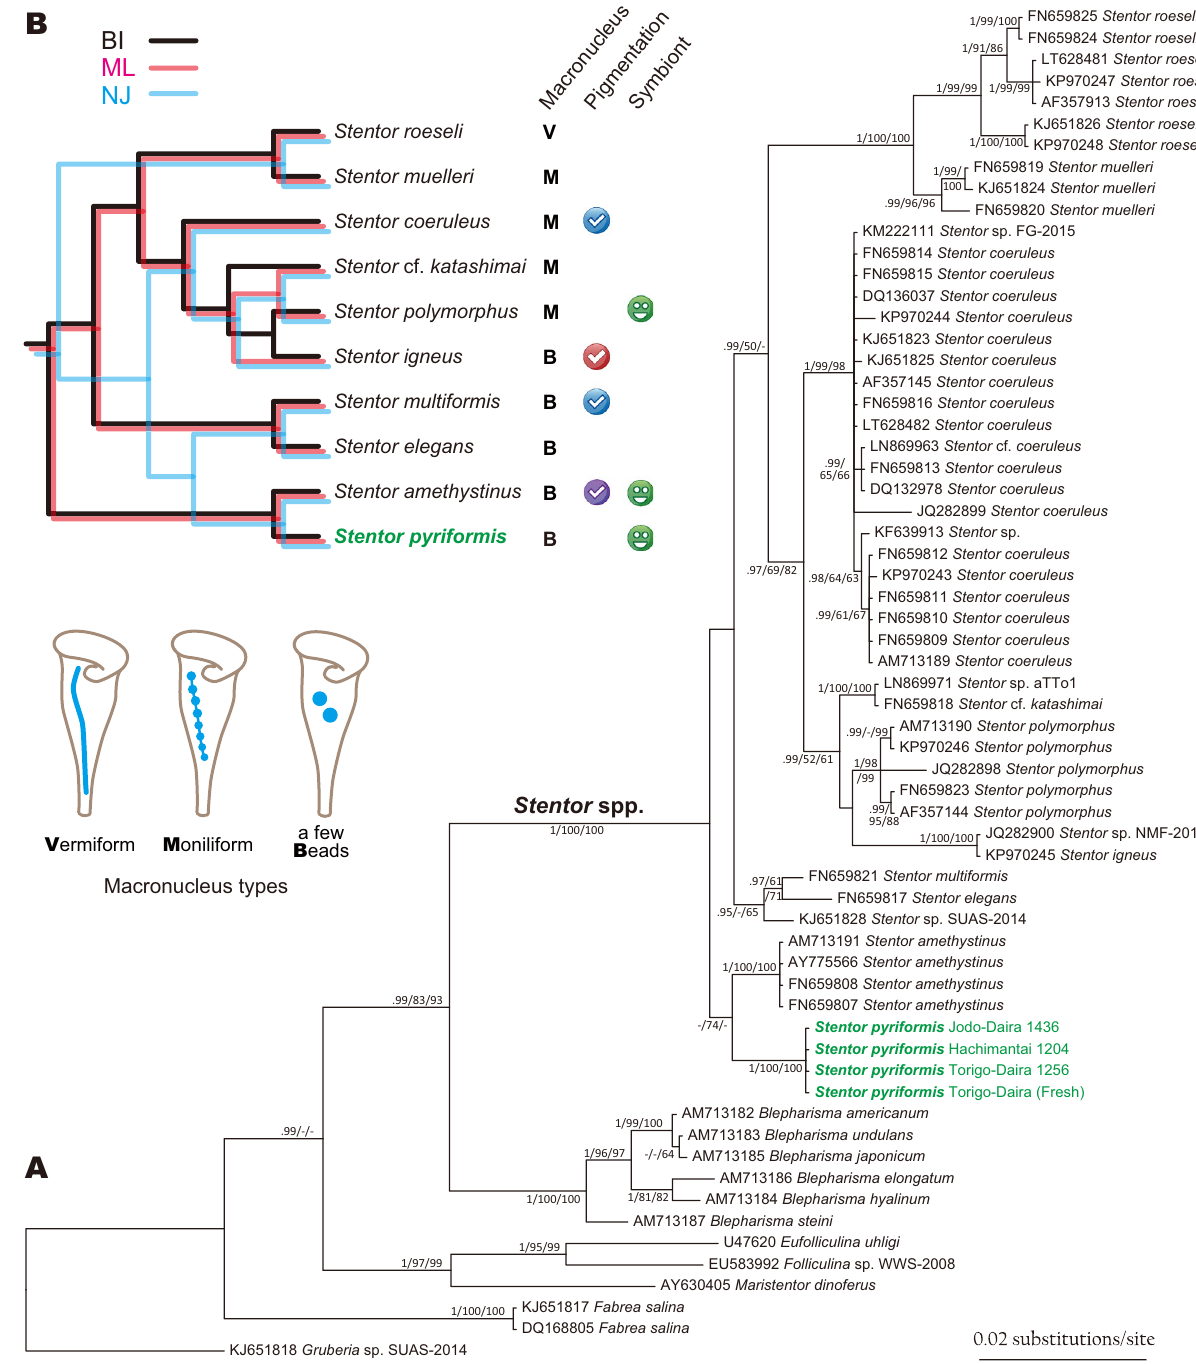
Figure 5. Phylogenetic relationships of Stentor species. ( A ). Bayesian inference tree for Stentor species based on SSU rDNA sequences. The tree was rooted with Gruberia sp. SUAS-2014. Numbers at the branches correspond to MrBayes posterior probabilities (PP)/maximum likelihood/neighbor-joining bootstrap values (BVs). Hyphens correspond to PP values below 0.70 and BVs below 50%. ( B ). Summary of the interspecific relationships and their iconic morphocharacters (shapes of macronucleus, presence or absence of cortical pigmentation and symbiotic algae). The figure explaining the varieties of macronuclei was modified from Foissner and Wölfl 8